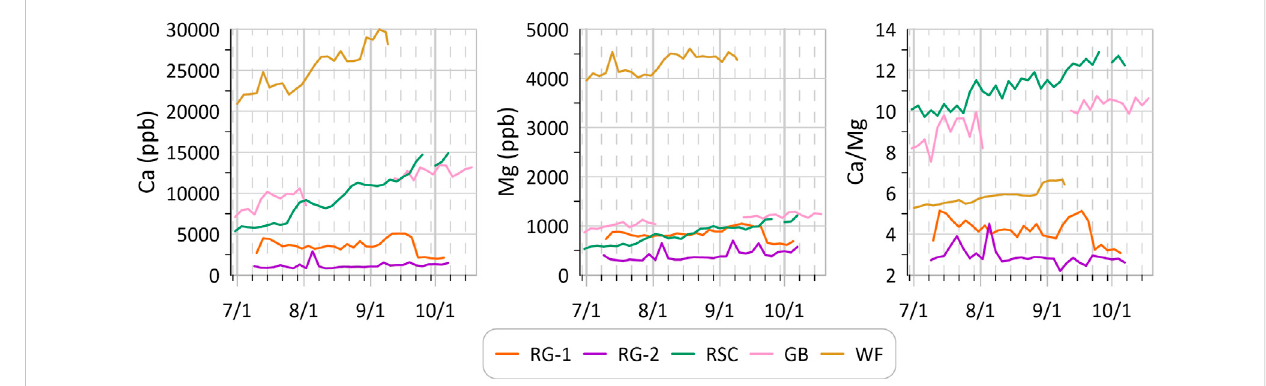
FIGURE 7 Time series of Ca, Mg, and Ca/Mg for the RG-1 and RG-2 water samplers in the Uinta Mountains, and RSC, GB, and WF in the La Sal